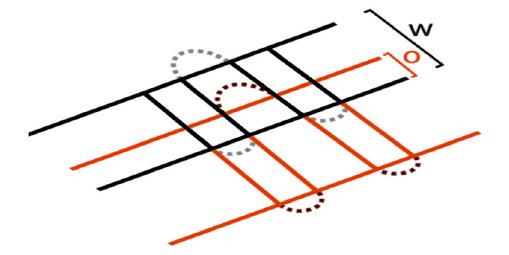
Figure 9. Example of controlled (p.s.) minor parameters like rotation angle, stripe width ( W ), overlap ( O ) or beam offset depend on the chosen exposure strategy (here: stripe exposure type) and should be investigated on their